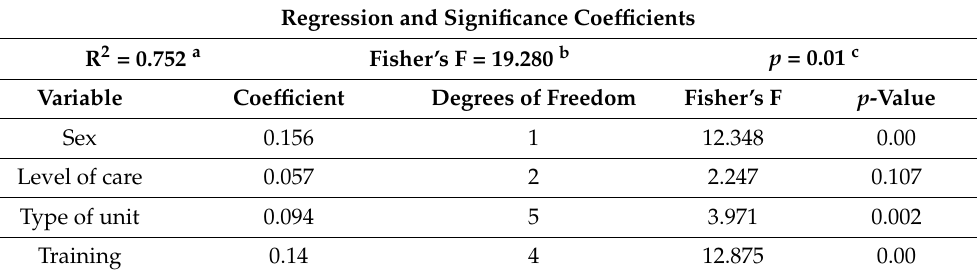
Table 3. Model adjustment and significance of the regression